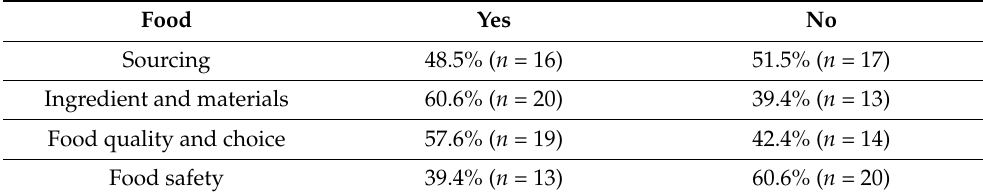
Table 9. Aspects of CSR activities: